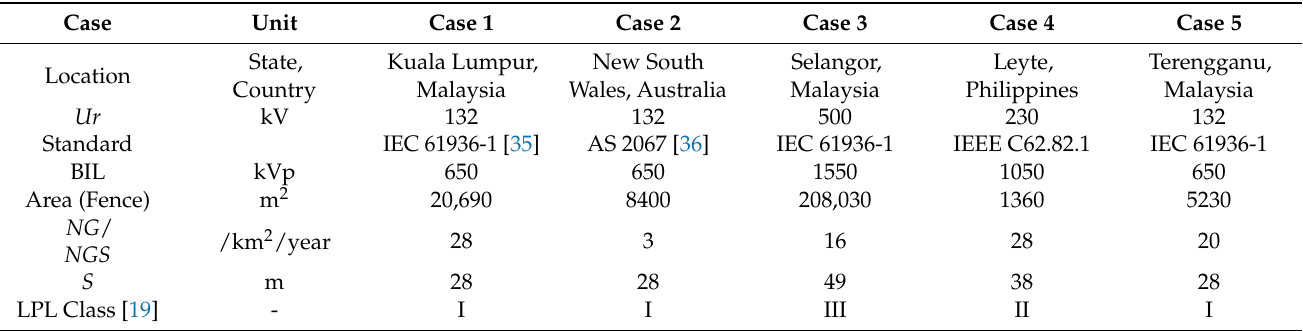
Table 6. Characteristics of the HV Substation Cases.